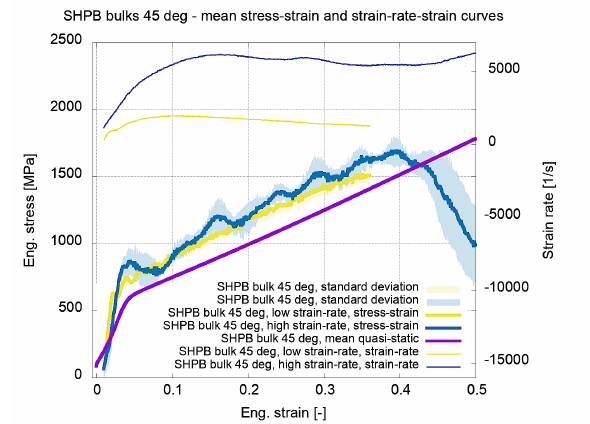
Figure 7. Mean stress-strain and strain-rate-strain curves evaluated from quasi-static and dynamic exper- iments with dog bone shaped specimens